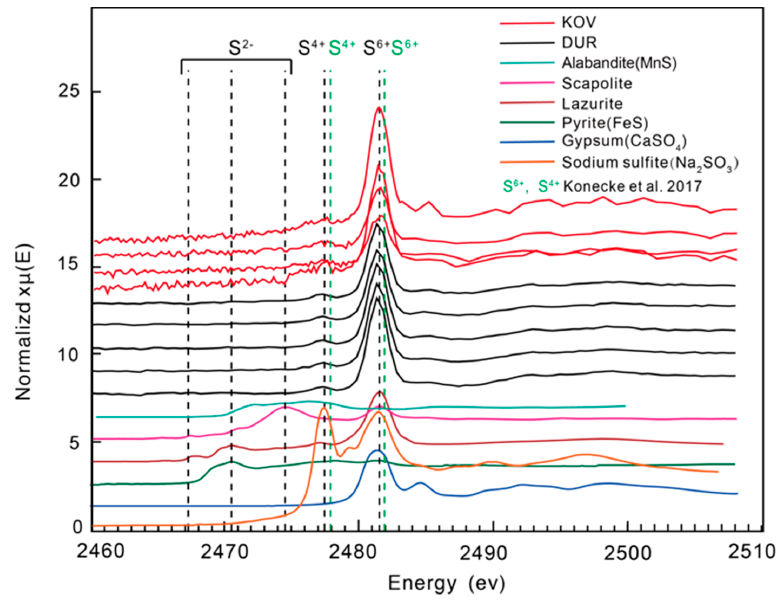
Figure 6. Sulphur XANES spectra of selected apatite samples from Durango, Kovdor and standard samples.